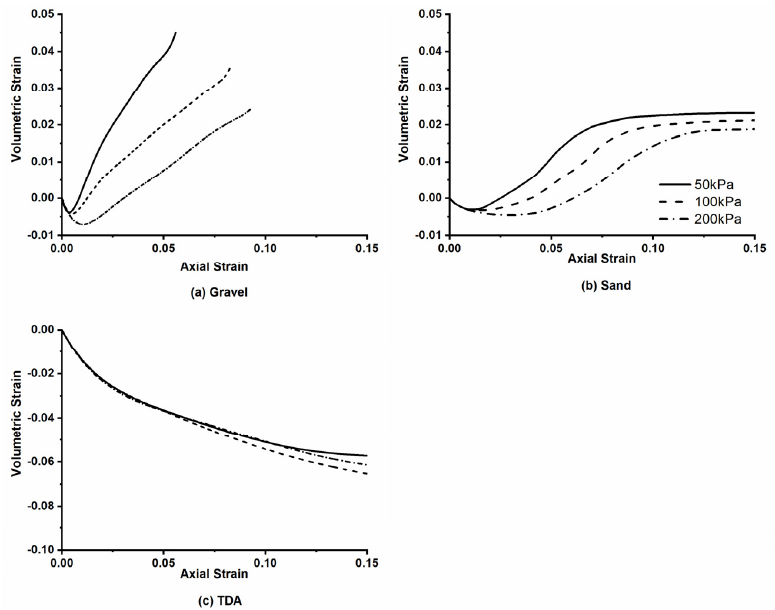
Figure 4. Volumetric strain versus axial strain for pure samples of the gravel, sand, and TDA used in the study at confining pressures of 50 kPa, 100 kPa, and 200 kPa.